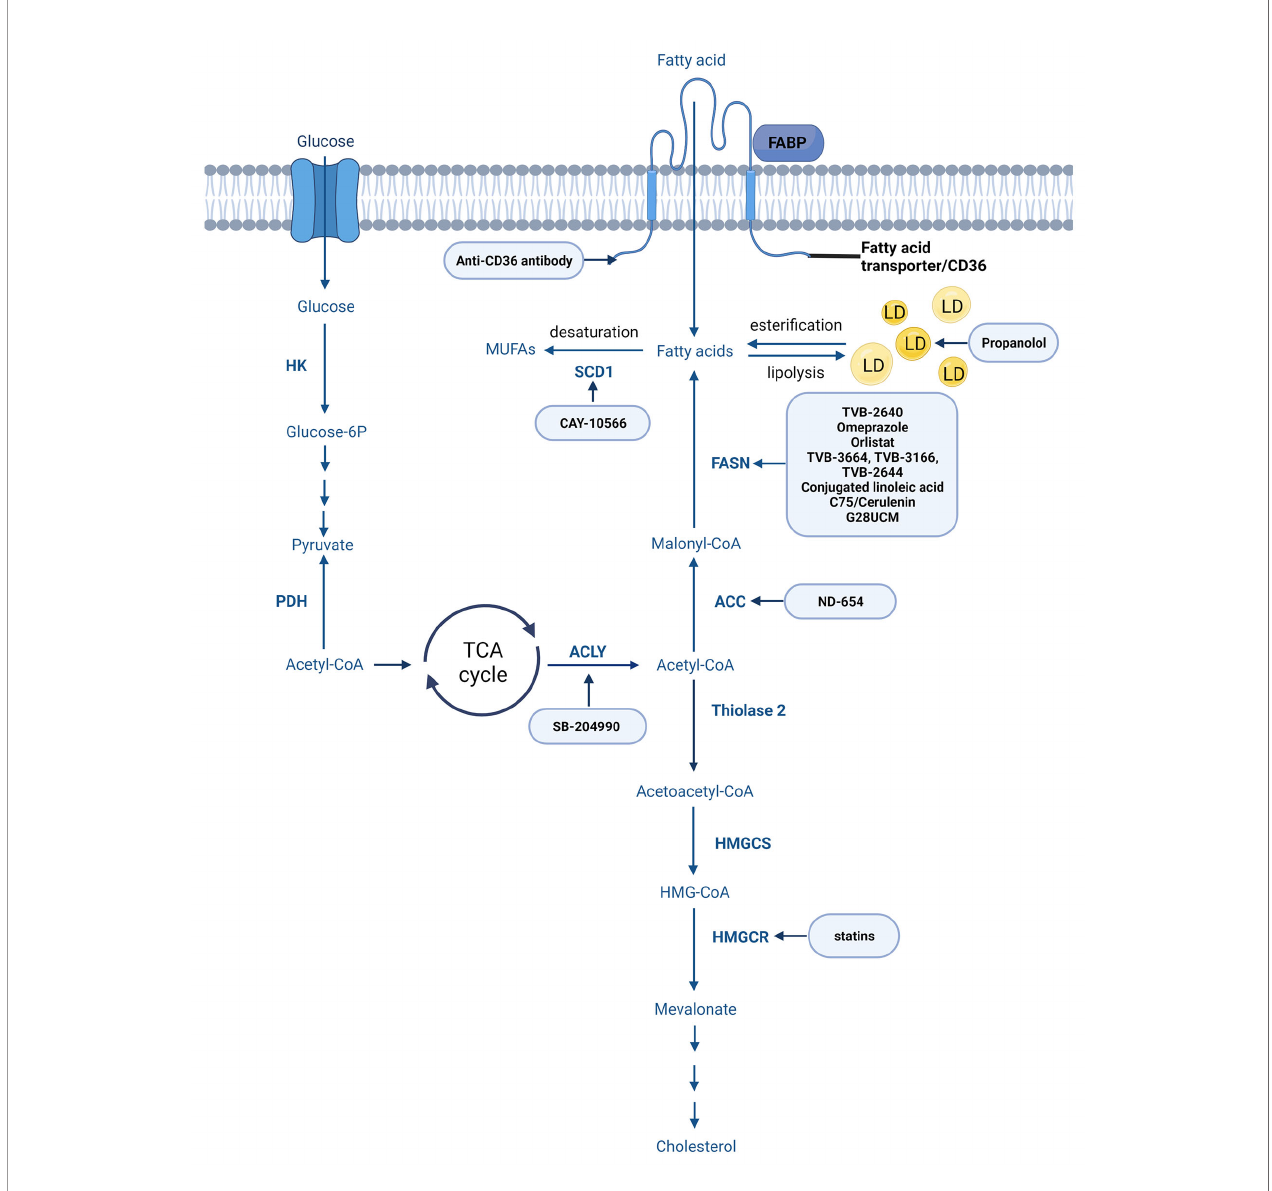
FIGURE 5 | Main steps of fatty acid and cholesterol synthesis. Created with BioRender.com. Agreement number: YB23MRDXCR.